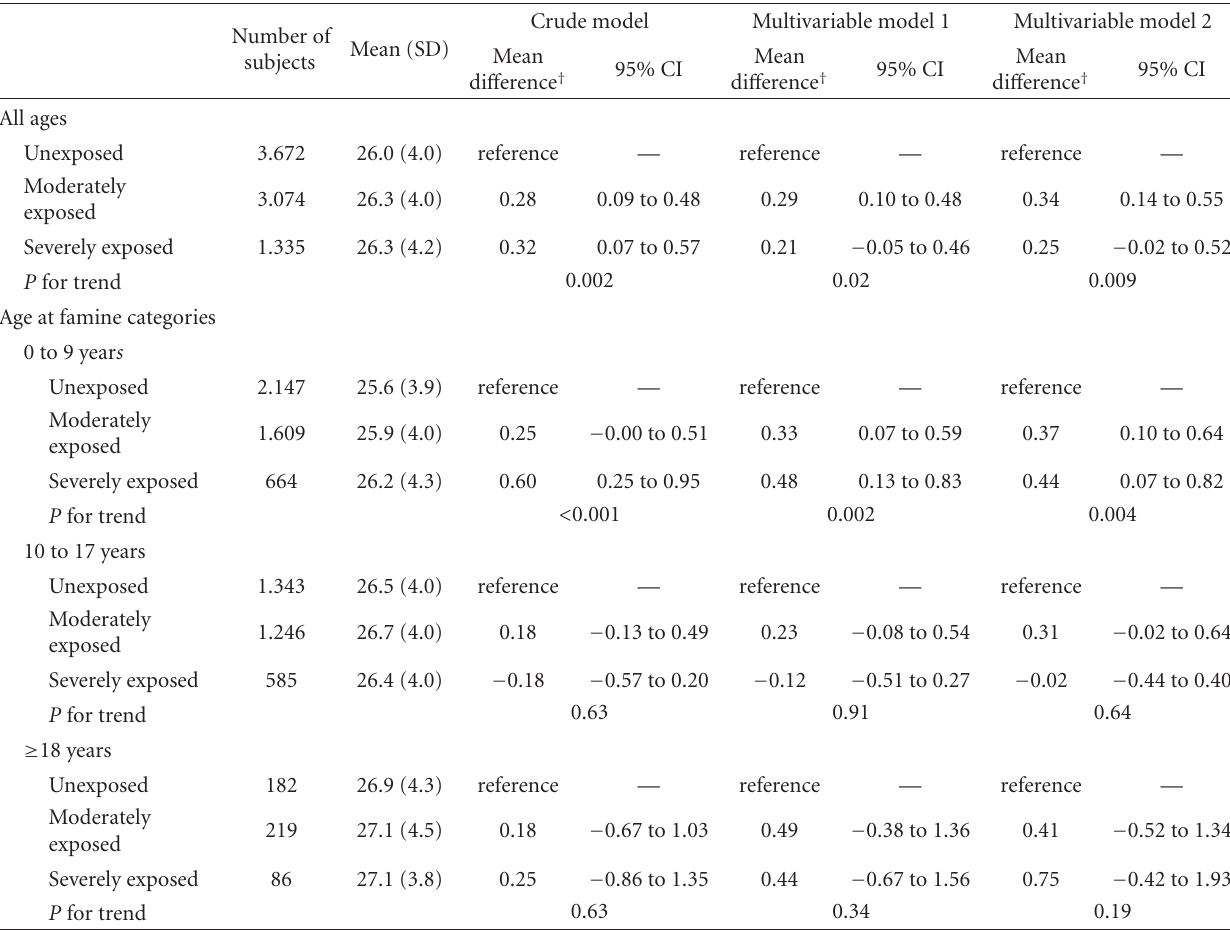
Table 2: BMI : means, (un)adjusted di ff erences, and 95% confidence intervals (CIs) for women of all ages combined and within each of the three exposure age categories: 0–9 years, 10–17 years, and ≥ 18 years who reported to be moderately or severely exposed to famine compared to those who reported to be unexposed to